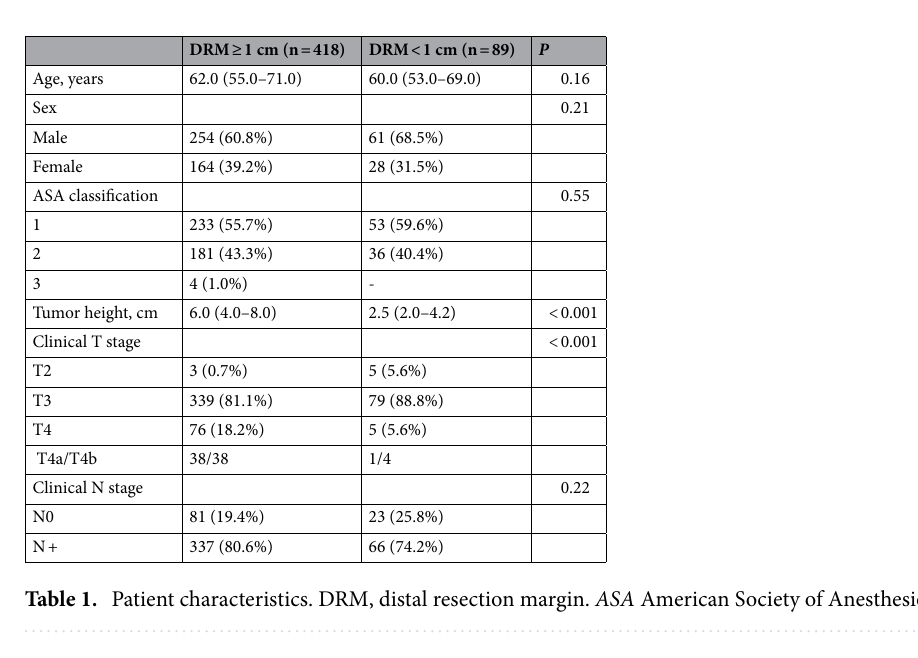
Figure 1. Study flow diagram.